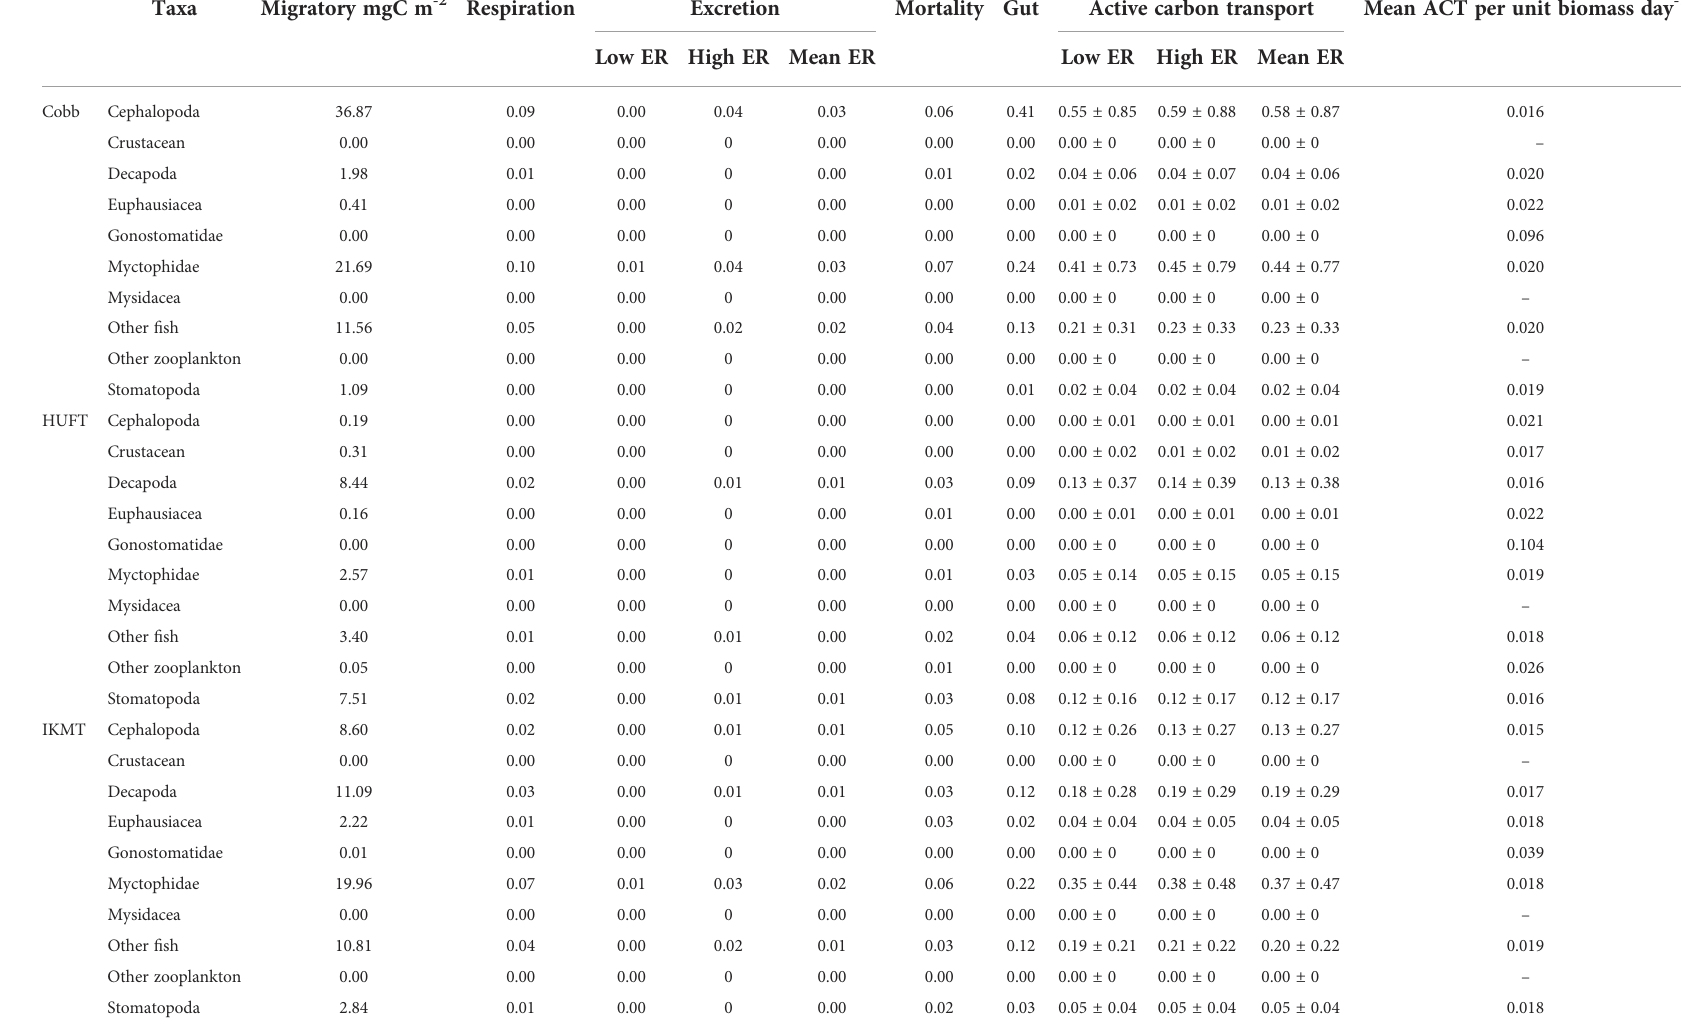
TABLE 4 Mean carbon fl uxes by trawl type and